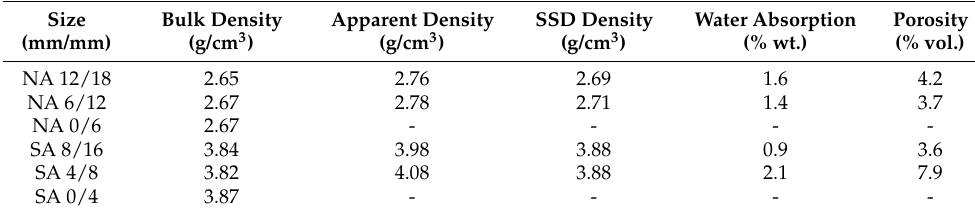
Table 2. Physical properties of the aggregates used.